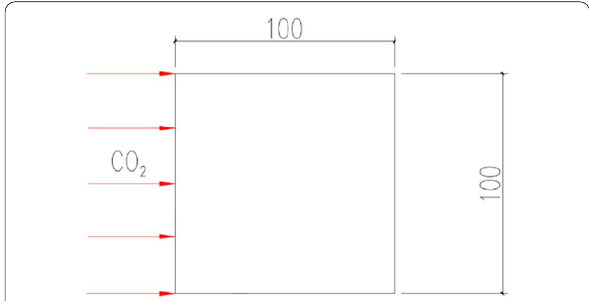
Fig. 6 Two-dimensional model of an experimental sample (size unit: